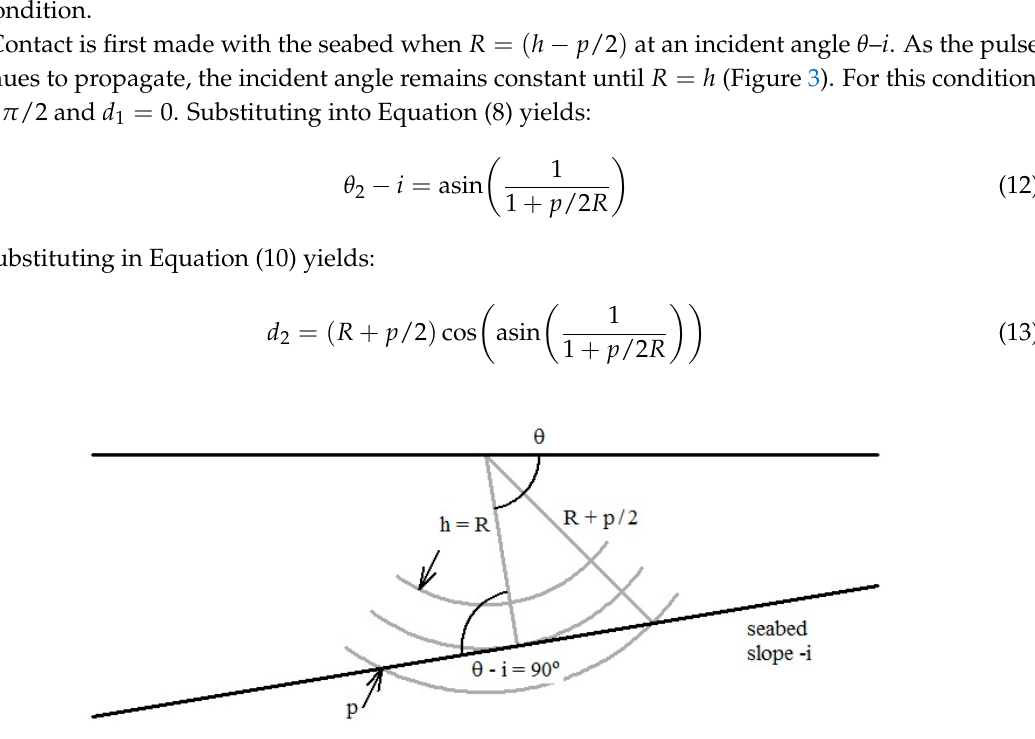
Figure 2. Geometry of acoustic rays for a sonar pulse intersecting the seabed for the critical inclination angle ( θ – i ) . Along-trace side view. The direction of the sonar vehicle is into the page. crit